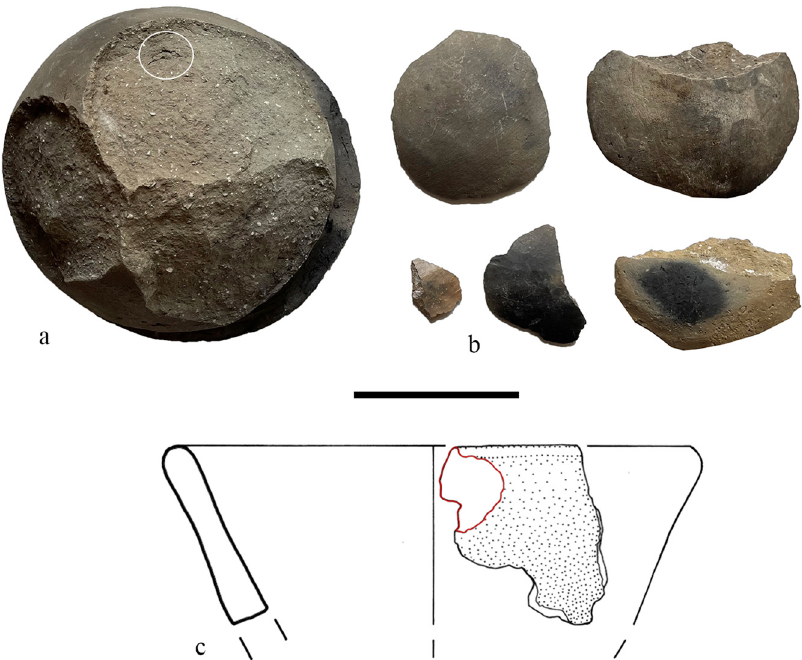
Figure 4: Experimental and archaeological spalls. ( a ) Negative of multiple spall detachments localised along the bottom and walls of an experimental clay bowl ( trace of an air bubble causing the spall highlighted in white ) ; ( b ) experimental spalls of diverse size and shapes; ( c ) illustration of an archaeological ceramic fragment from Portonovo with a negative of spall detachment highlighted in red. The experimental examples a and b are part of a reference collection of pottery fi ring of Vanessa Forte. Black bar is